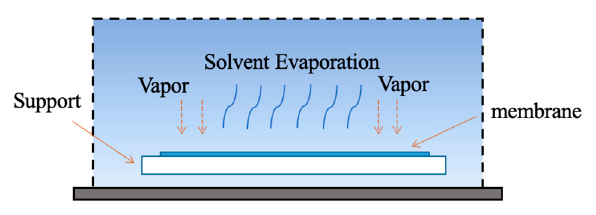
Figure 18. Process for VIPS method.